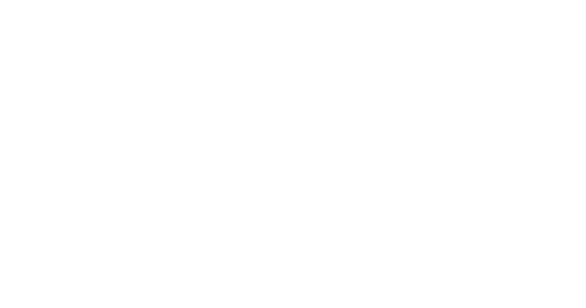
Figure 1. Relative mRNA level of CLDN6 gene in bovine CCs was analyzed using RT-qPCR. Results were normalized to the mRNA level of GAPDH . Data are shown as means ± SD from three independent experiments. * p < 0.05.